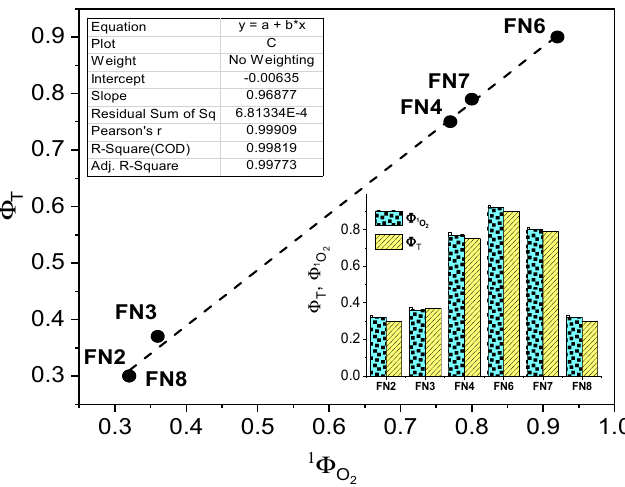
Figure 7. Comparison of the quantum yield of singlet oxygen generation to the quantum yield of triplet state formation for selected sensitizers.